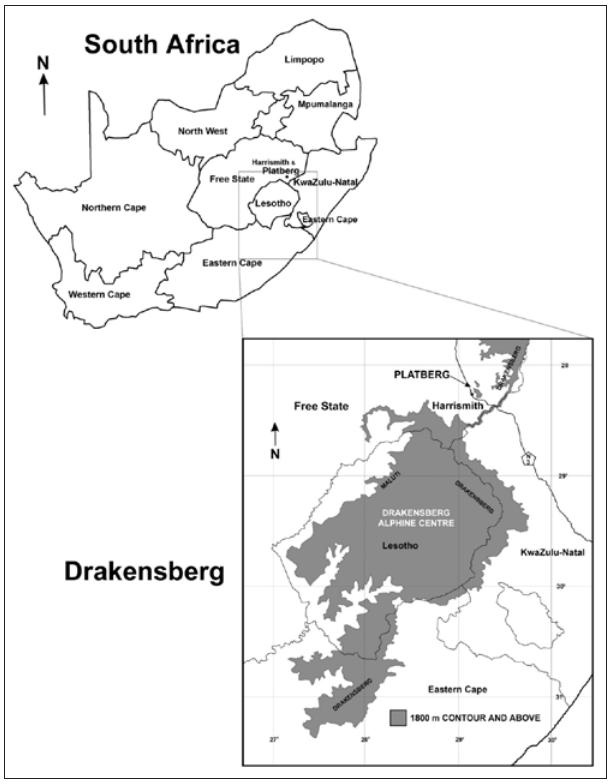
FIGURE 1: Location of the study